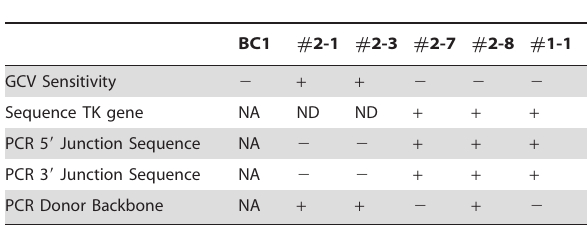
correctly inserted at the OCT4 locus could be obtained. As shown in Fig. 5A, the nucleofection efficiency using the pmaxGFP plasmid was high for BC1 cells. After nucleofection using the TK- 2A-Puro donor plasmid and plasmids encoding the OCT4 ZFN # 2, 10 puromycin-resistant cell clones were obtained. There were no colonies when the cells were transfected with the donor plasmid alone. Five of these clones were lost during expansion slowly. Of the five remaining clones (clones # 1-1, 2-1, 2-3, 2-7 and Table 2. Characteristics of BC1 cell-derived